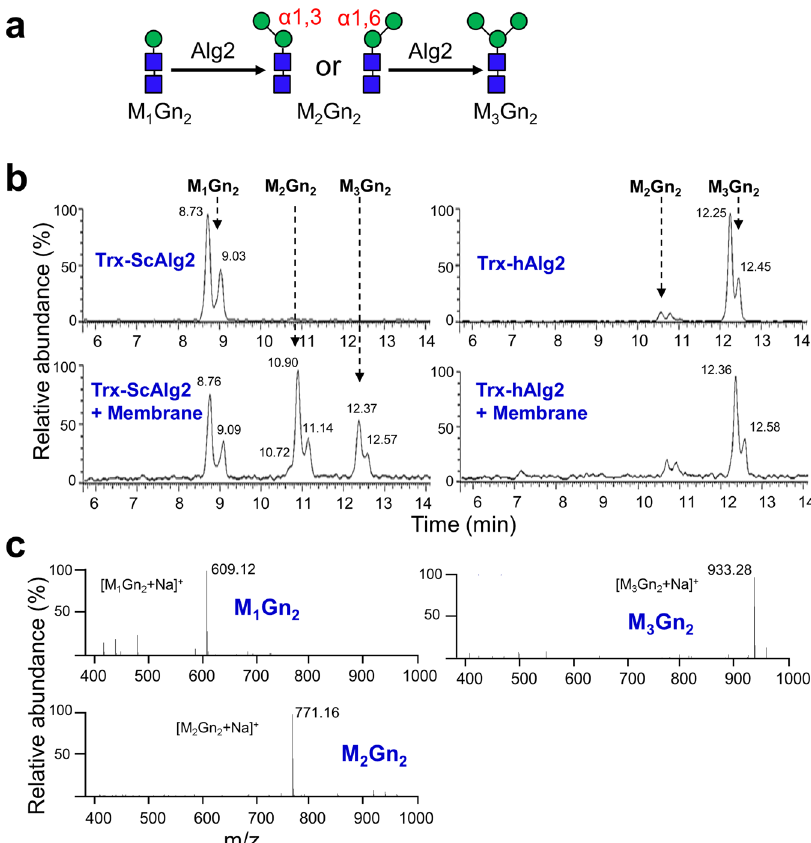
Fig. 4 Comparison of MTase activity between hAlg2 and ScAlg2. a Schematic diagram of the reaction catalyzed by Alg2. Alg2 transfers Man to M 1 Gn 2 in either an α 1,3- or α 1,6-linkage, to produce two different M 2 Gn 2 intermediates. b The UPLC chromatograms of glycan chains released from the Alg2 reaction mixtures. Reactions were performed using puri fi ed Trx-ScAlg2 or Trx-hAlg2 (40 ng/ μ L) with the standard reaction mixture. After mixing, heat-inactivated E. coli membrane was added upon request and reactions incubated at 30 °C for 4 h. c ESI-MS spectra of the glycans released from phytanyl oligosaccharides. Mass analyses showed the peaks eluted (Fig. 4b) at ~ 8.9 min, ~ 11.0 min and ~ 12.4 min correspond to M 1 Gn 2 ([M 1 Gn 2 + Na] + ), M 2 Gn 2 ([M 2 Gn 2 + Na] + ) and M 3 Gn 2 ([M 3 Gn 2 + Na] + ), respectively. of the natural M 1 Gn 2 -PDol acceptor (see Methods for details). Table 2 Relative percentage of oligosaccharides produced by Alg2 in various reaction conditions.